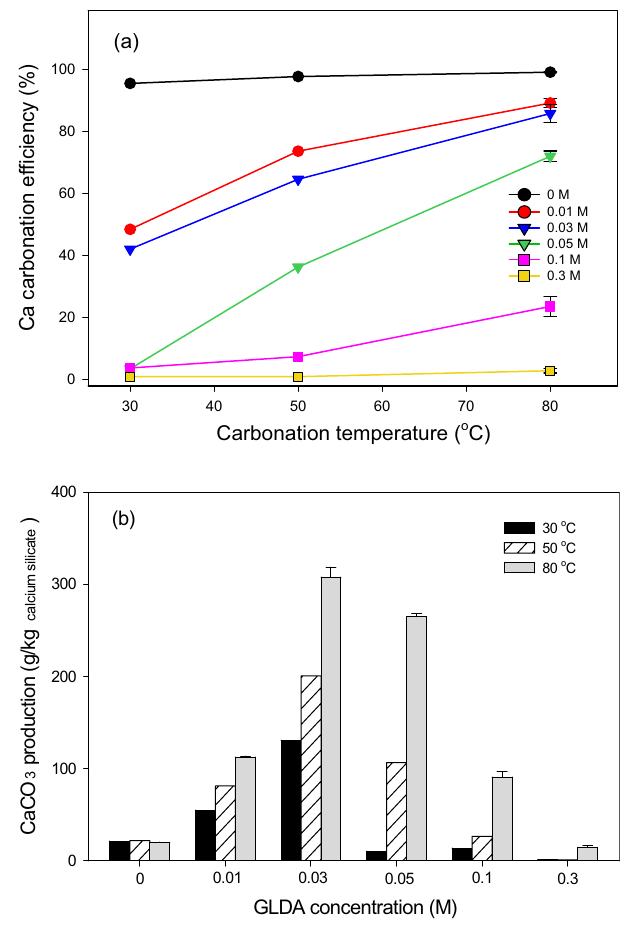
Figure 8. Effects of temperature and GLDA concentration on ( a ) the Ca carbonation efficiency obtained after 60 min using 0.3 M Na 2 CO 3 , and ( b ) CaCO 3 production efficiency. Carbonation experiments conducted at 80 °C were repeated twice and the average values were